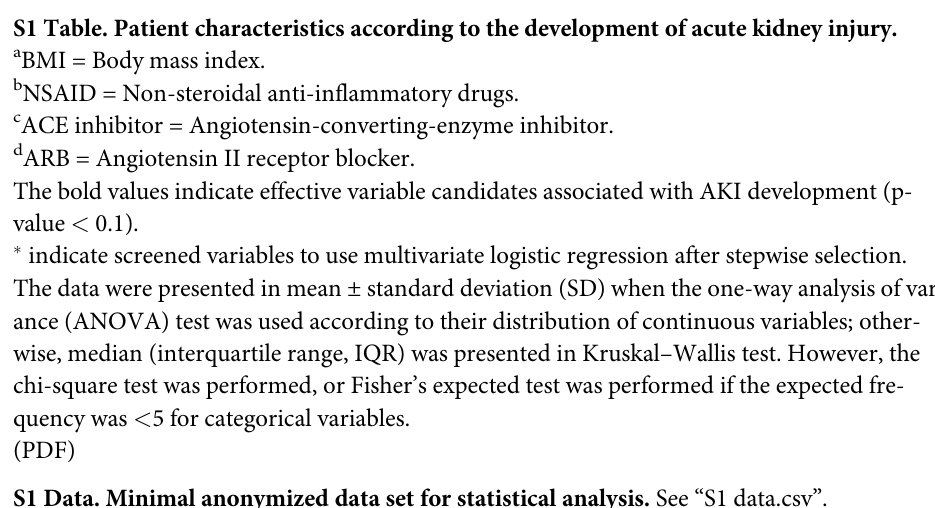
S1 Table. Patient characteristics according to the development of acute kidney injury. a BMI = Body mass index.